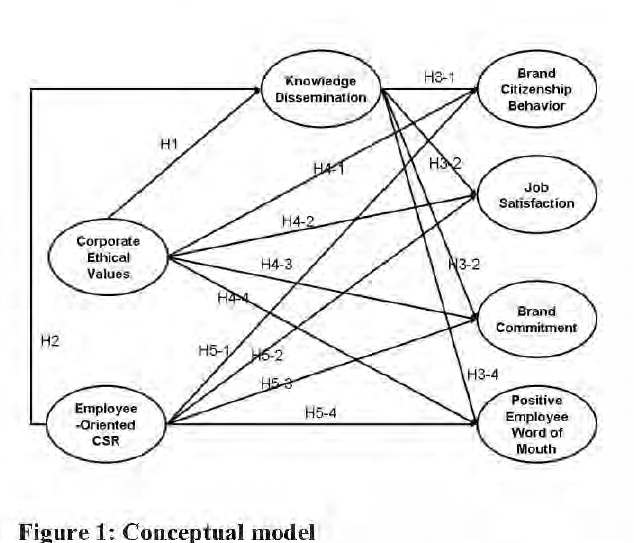
Figure 1: Conceptual